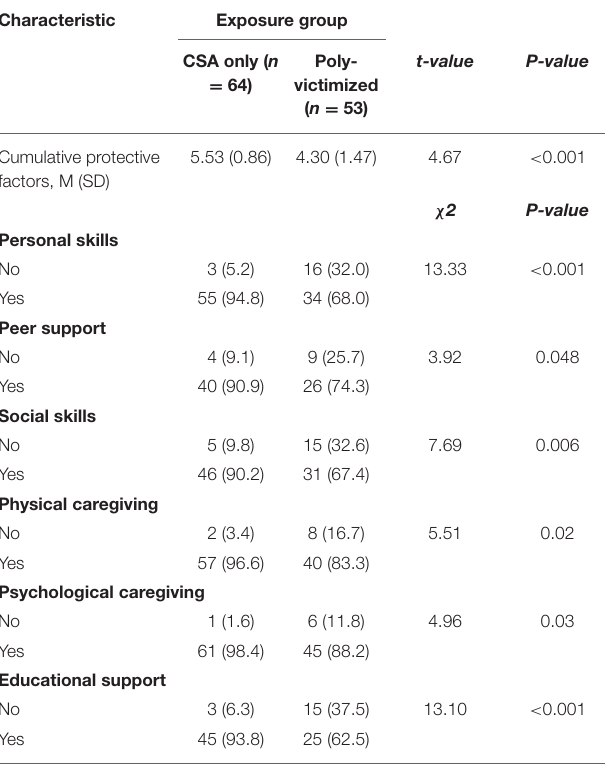
TABLE 7 | Unadjusted and adjusted regression analyses for cumulative trauma symptoms. Variable